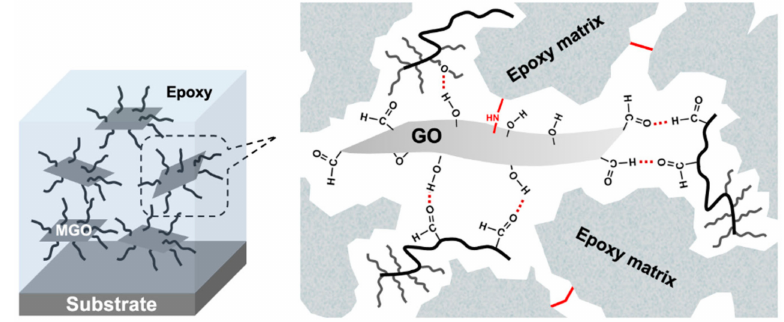
Figure 5. Schematic illustration of the dispersed mechanism of